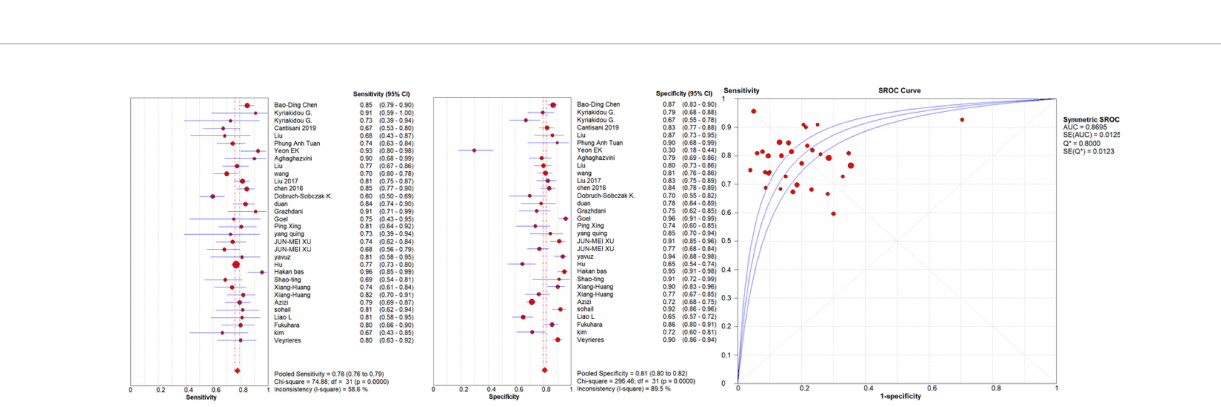
FIGURE 2 | Sensitivity and speci fi city forest plots and SROC curve for the semiquantitative USE. The circle size represents the nodule population of the selected articles; the line represents the con fi dence interval of the selected articles.